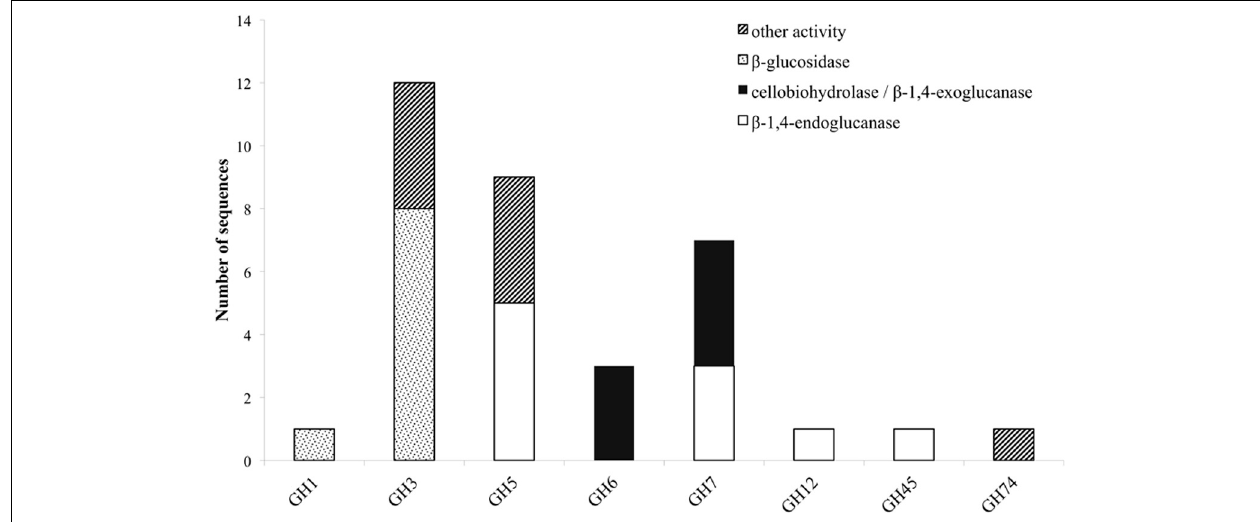
FIGURE 1 | Distribution of cellulolytic enzymes of M. thermophila throughout eight GH families. Other activities refer to β -xylosidase (GH3), β -1,6-galactanase, β -1,3-glucanase,